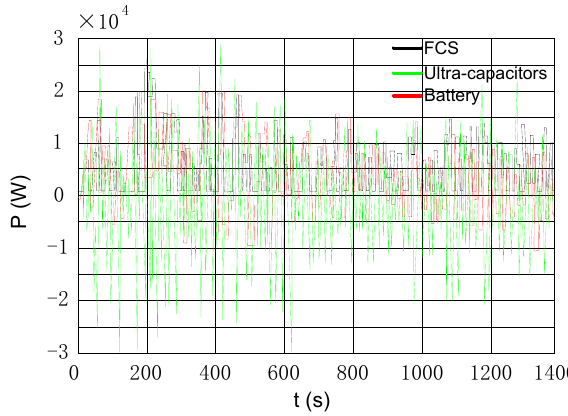
Figure 19. Output power of the FCS, battery and ultra-capacitors.